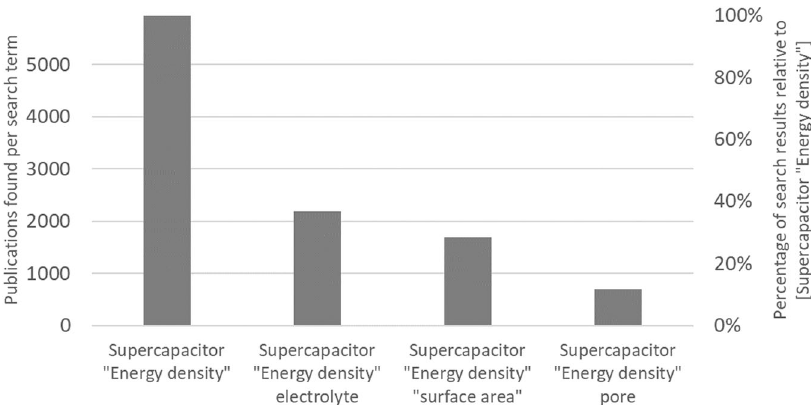
Fig. 1 Number of publications in the fi eld of supercapacitors focusing on different methods for energy density increase. Data collected in January 2022 using the Mendeley database and selecting the year interval 2019 – 2022. The searched terms were: (i) [Supercapacitor] (resulting in 13,287 total publications – value not shown in the graph), (ii) [Supercapacitor “ Energy density ” ] (resulting in 5945 publications, i.e., 45% of the [Supercapacitor] result), (iii) [Supercapacitor “ Energy density ” electrolyte] (resulting in 2189 publications, i.e., 37% of the [Supercapacitor “ Energy density ” ] result), (iv) [Supercapacitor “ Energy density ” “ surface area ” ] (resulting in 1684 publications, i.e., 28% of the [Supercapacitor “ Energy density ” ] result) and, (v) [Supercapacitor “ Energy density ” pore] (resulting in 699 publications, i.e., 12% of the [Supercapacitor “ Energy density ” ]